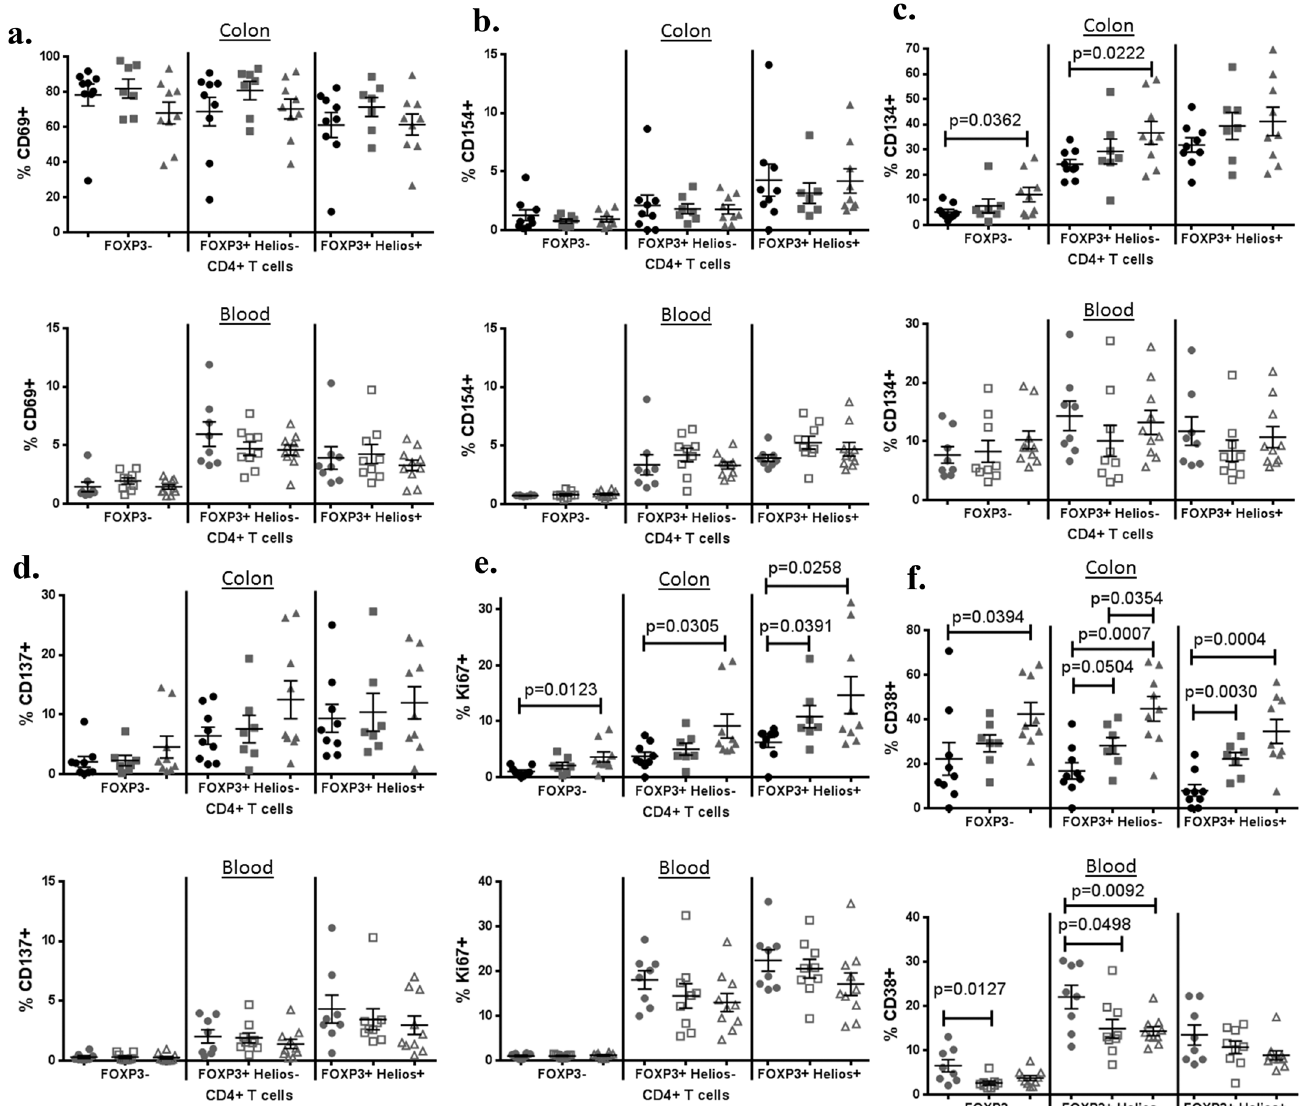
Fig 5. Tregs express activation markers in IBD no less than in controls. The percent of CD3 + , CD4 + LPL (upper panels) or PBMC (lower panels) expressing CD69 (a), CD154 (b), CD134 (c), CD137 (d), Ki67 (e), or CD38 is shown for non-IBD colon (black circles), the uninflamed (gray squares) or inflamed (gray triangles) colon from IBD patients (11 UC, 5 Crohn ’ s), or for blood from Crohn ’ s patients with (open gray triangles) or without (open gray squares) active symptoms (diarrhea, pain, and or bleeding), or from age/gender-matched healthy control subjects (gray circles). Positivity is relative to an isotype-matched control antibody for each